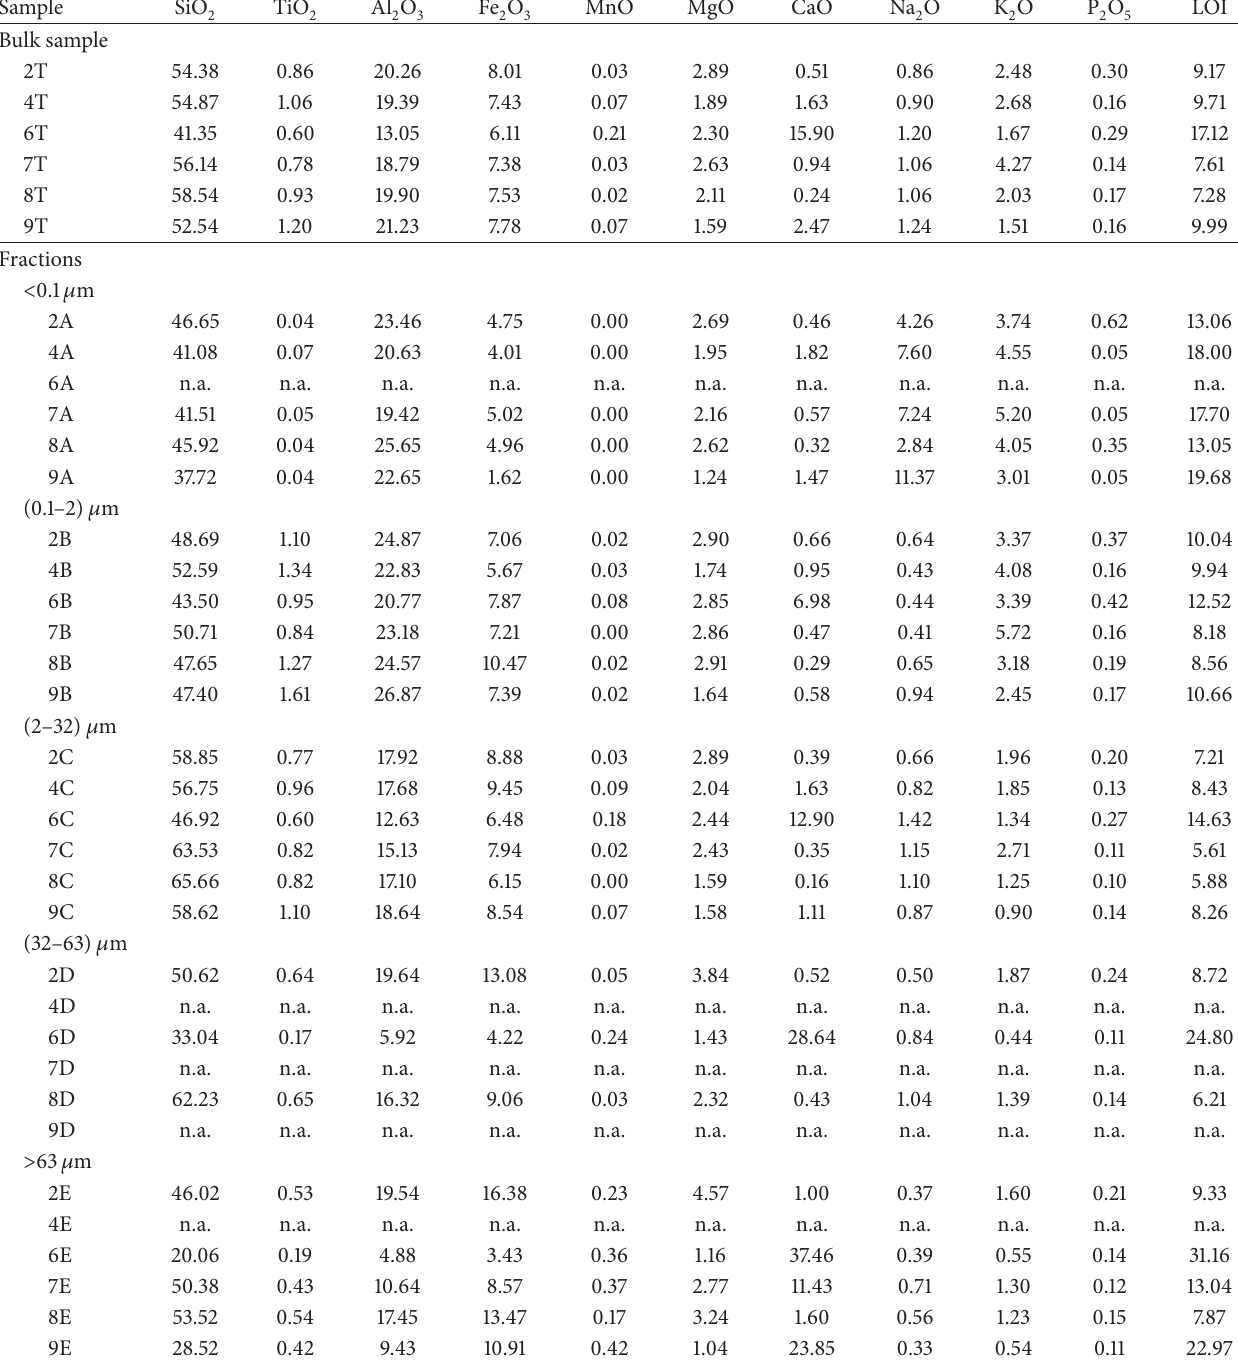
Table 2: Chemical composition (wt%) of the bulk sample and different